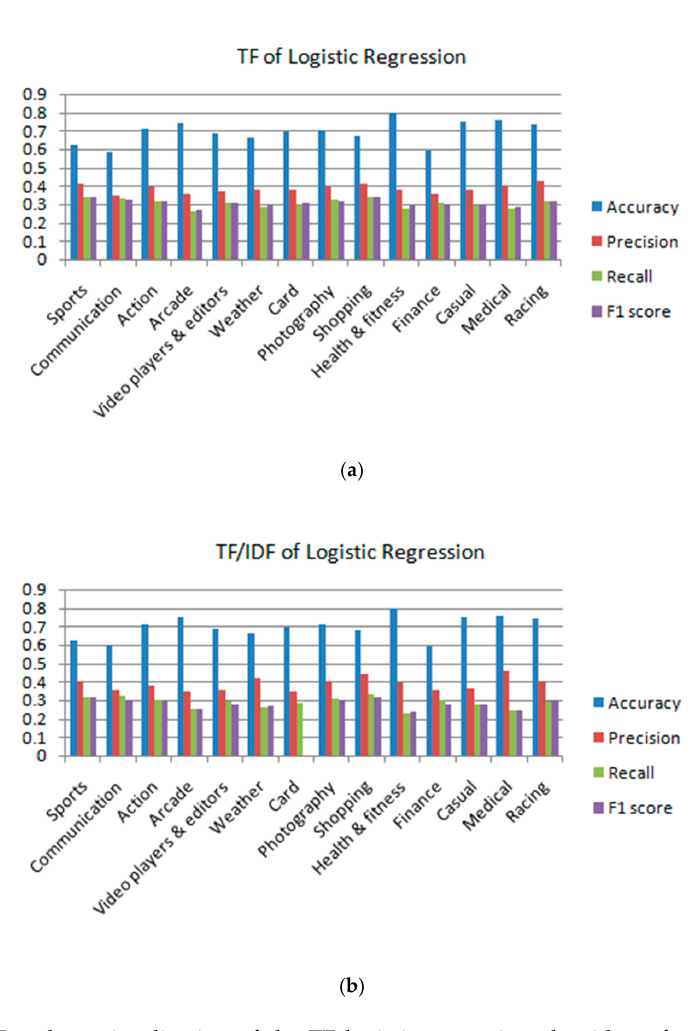
Figure 5. ( a ) Bar-chart visualization of the TF logistic regression algorithm after preprocessing; ( b ) bar-chart visualization of the TF / IDF logistic regression algorithm after preprocessing.